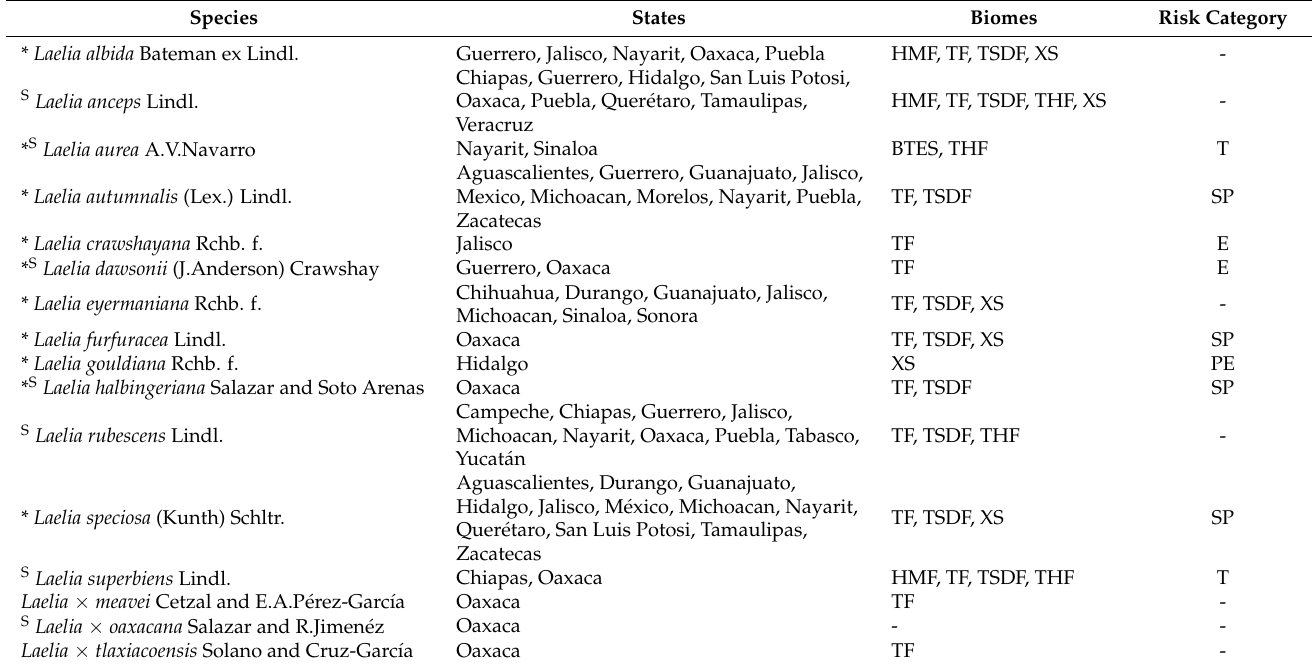
Table 1. Distribution of the species of Laelia s.l. in Mexico by political division, by biomes following the classification by Villaseñor and Ortiz [39], and by risk category according to the NOM-059- SEMARNAT-2010